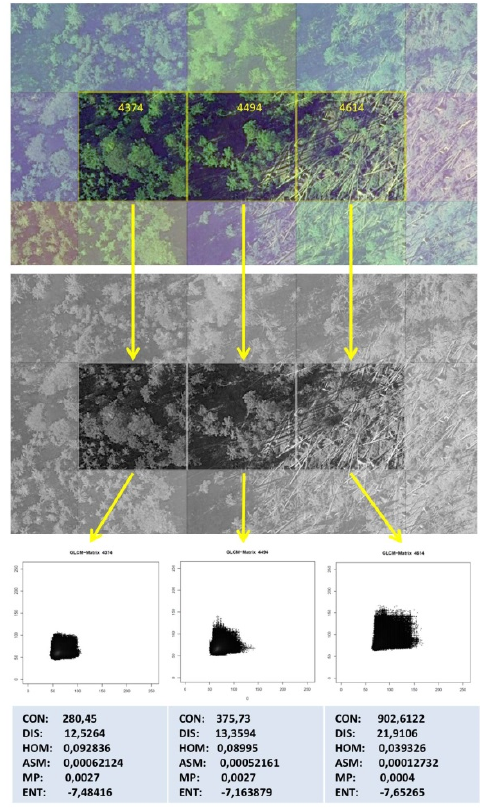
Figure 2. Visual representation of the underlying cell-wise workflow of this study. In the top line, three raster cells numbering 4374, 4494, and 4614 with different windthrow intensities are shown. The grey line below represents the step where RGB values are turned into grey-level values. In the line below, grey-level cooccurrence matrix (GLCM) value distributions are shown. In the last grey section, the calculated texture metrics are shown for the raster cells with differing windthrow intensities.